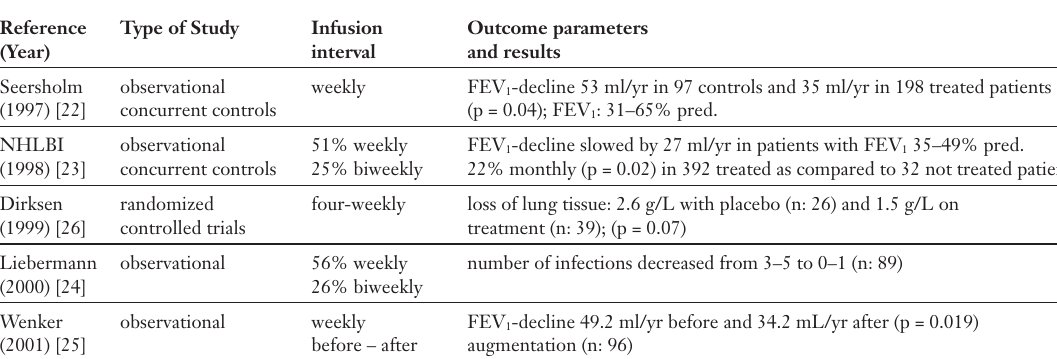
Table 1 Published studies on the clinical efficacy of AAT augmentation